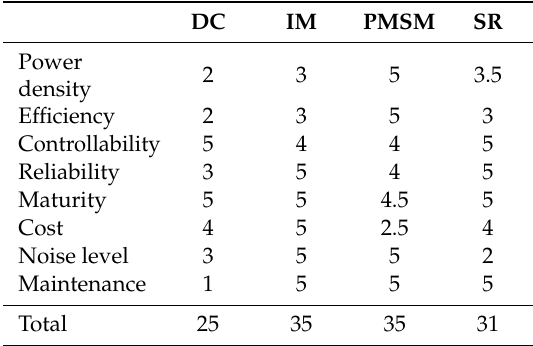
Table 4. Evaluation of existing machines for